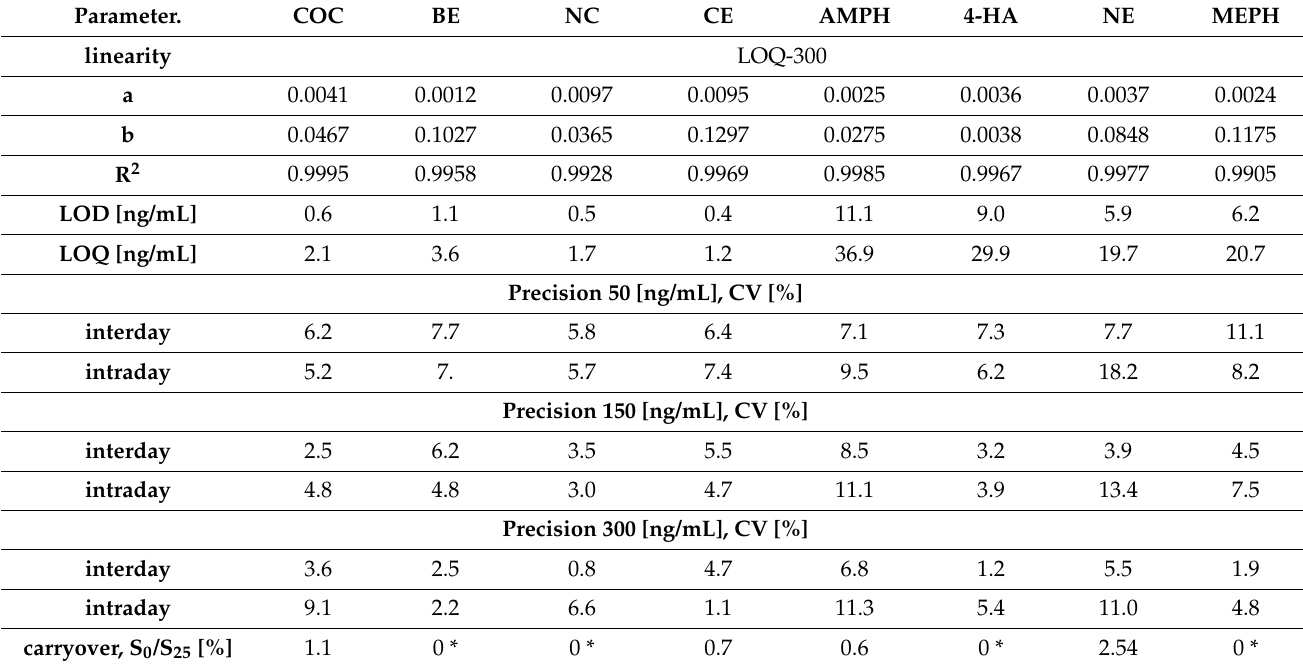
Table 1. Summary of the validation parameters for the DI-SPME/LC-MS